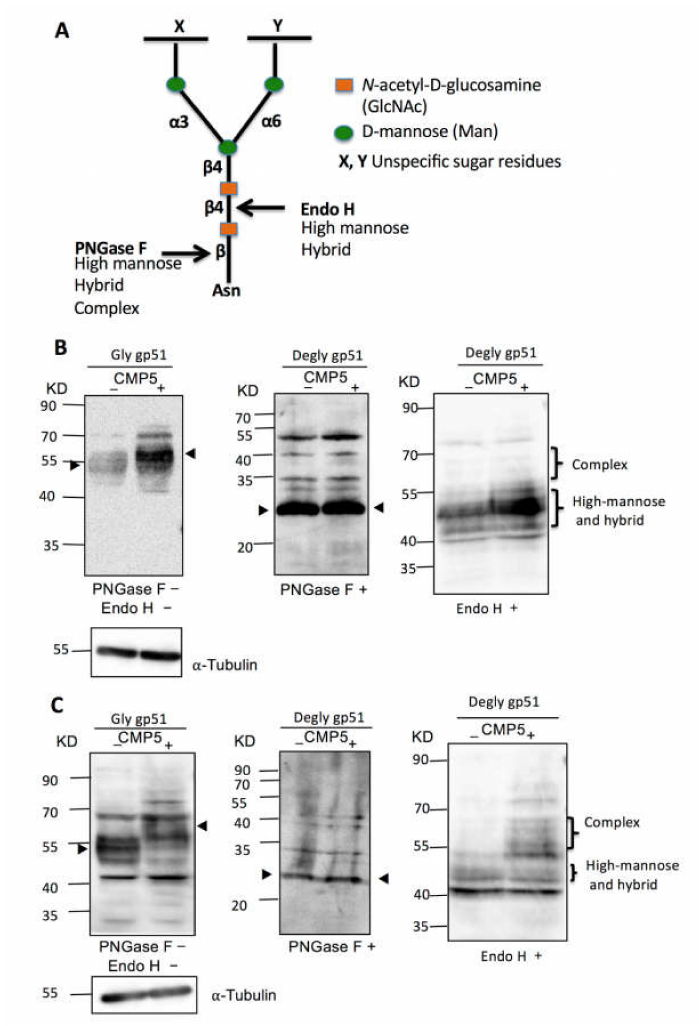
Figure 7. Deglycosylation assay of BLV gp51 using PNGase F and endo H. ( A ) Schematic representation of PNGase F and Endo H sensitive bonds in the core of N -glycans. ( B ) FLK-BLV or ( C ) PK15-BLV